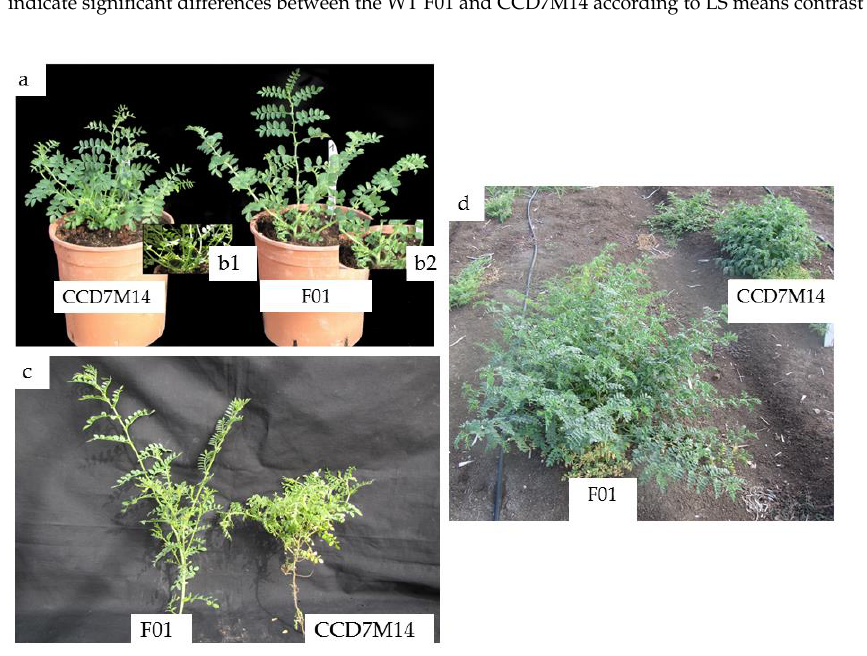
Figure 2. Morphological differences between WT F01 and CCD7M14. ( a ) One-month-old WT F01 (right) and CCD7M14 (left) plants grown in a net house. (b1 and b2) Stem distribution on the lower section of the plants. ( c ) Primary branches of WT F01 (left) and CCD7M14 (right) plants. ( d ) Three-month-old WT F01 (left) and CCD7M14 (right) plants in the field. Analysis of carotenoid, chlorophyll, and anthocyanin contents in the first, third, and fifth leaves revealed significant decreases in carotenoids and chlorophylls, and an increase in anthocyanins in the mutant as compared to its parental line (Table 5). Table 5. Contents of carotenoids, chlorophyll, and anthocyanins ( µ g per 1 g of fresh leaf biomass) in the leaves of WT F01 and CCD7M14.